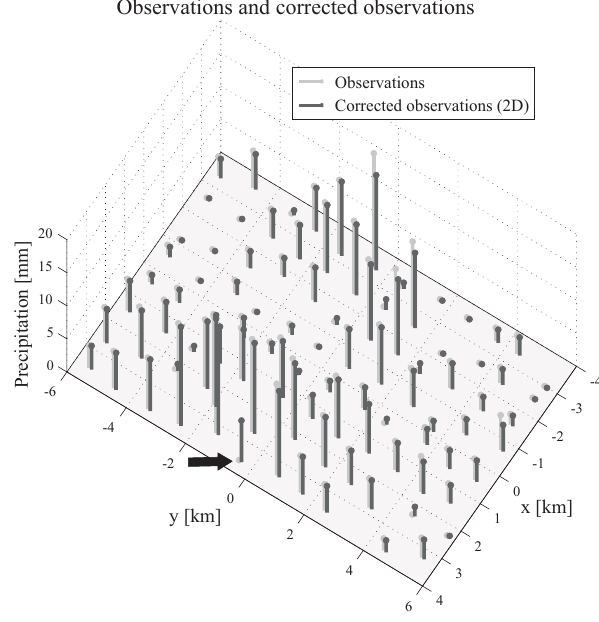
Fig. 12. Presentation of the observed 10min precipitation values on 20 June 2007, 21:40UTC as light gray bars. The dark gray bars mark the corrected observations after a two dimensional ( x , y ) VERA-QC (without gross error recognition) was applied. The black arrow points at a station that was located within a field of heavy precipitation but nevertheless was stuck at a reading of zero millimeters. This malfunction could be observed for the entire pe- riod of 20 June